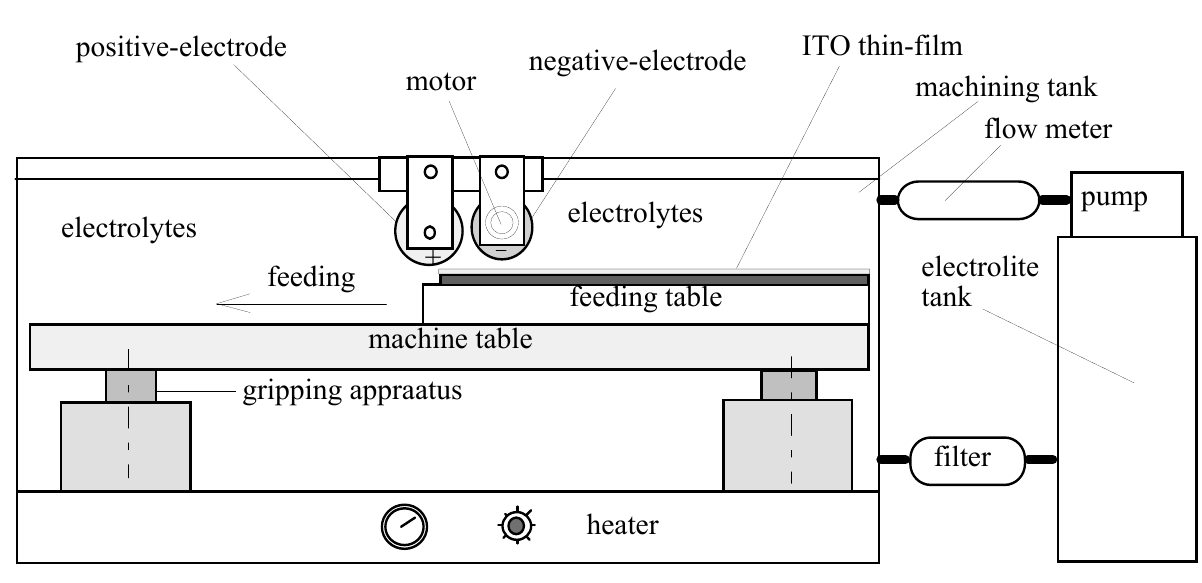
Figure 1. Experimental setup.